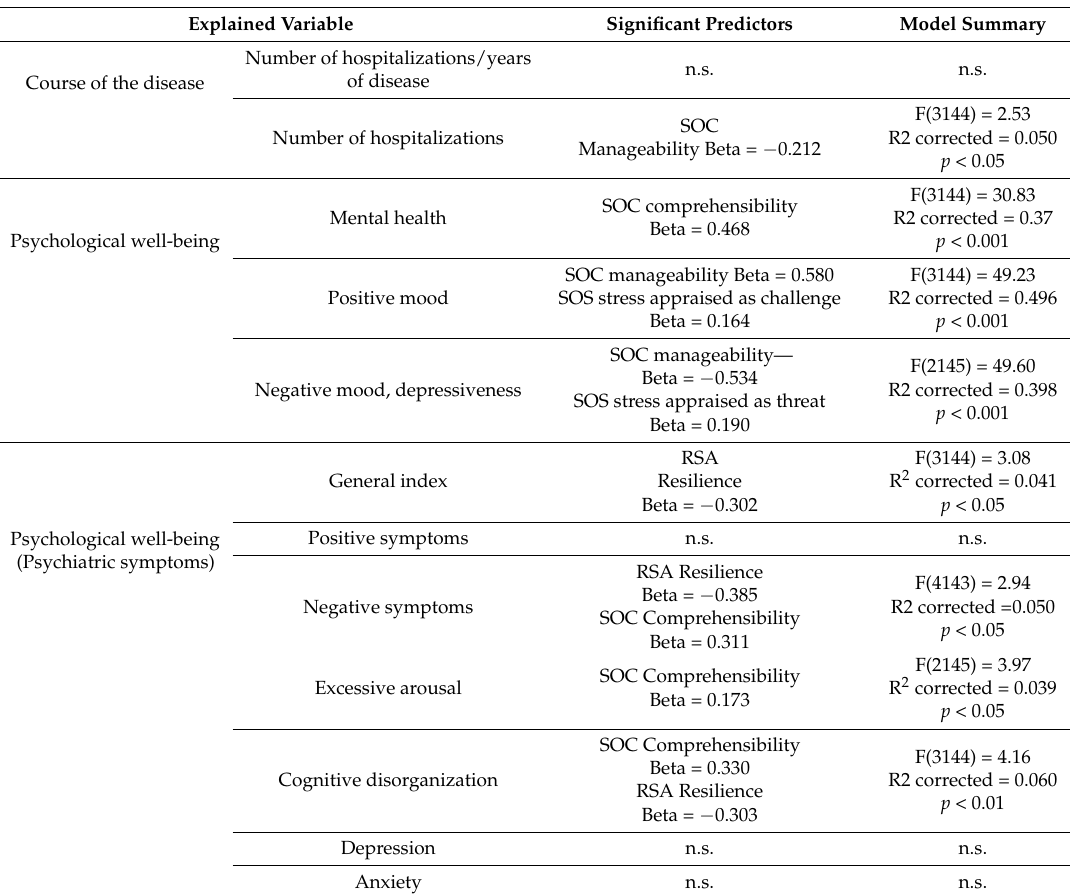
Table 3. Summary of the regression model for the explained research